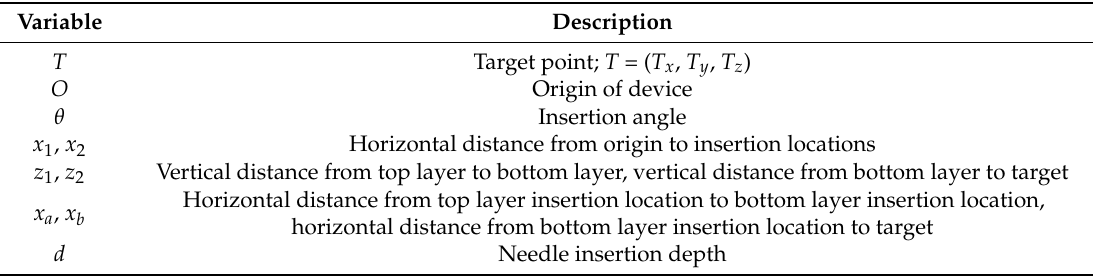
Table 1. Variables in needle insertion location Equations